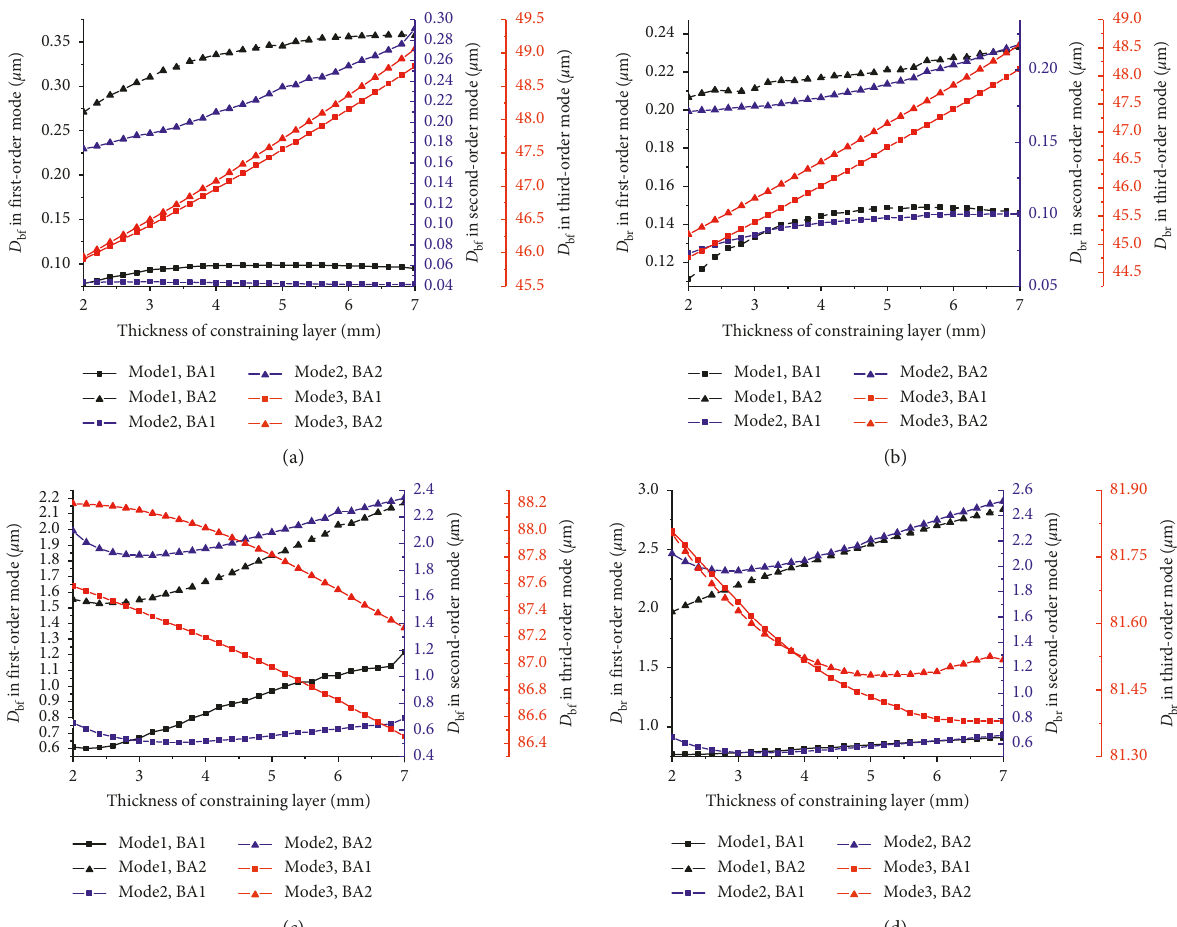
Figure 12: Displacement deviation between foundation and constraining layers in the position of the bracket. (a) Position I, upper constraining layer. (b) Position I, lower constraining layer. (c) Position II, upper constraining layer. (d) Position II, lower constraining layer.